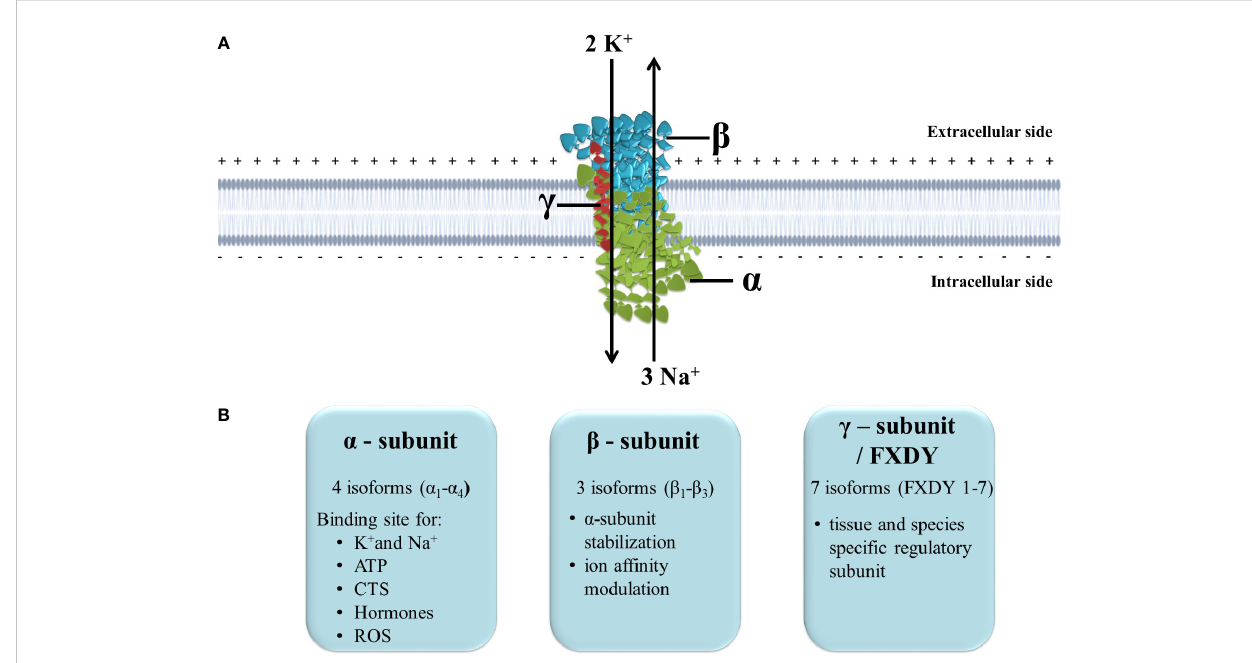
FIGURE 1 The structure and function of Na + /K + -ATPase. (A) Position of Na + /K + -ATPase in the plasma membrane and maintenance of ion homeostasis; (B) Subunits isoforms and speci fi c function. ATP, adenosine triphosphate; CTS, cardiotonic steroids; ROS, reactive oxygen